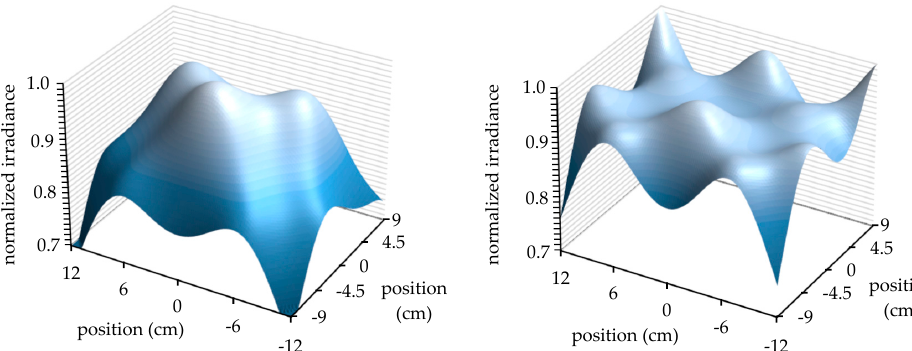
Figure 10. Calculated normalized irradiance before (left) and after (right) optimization.